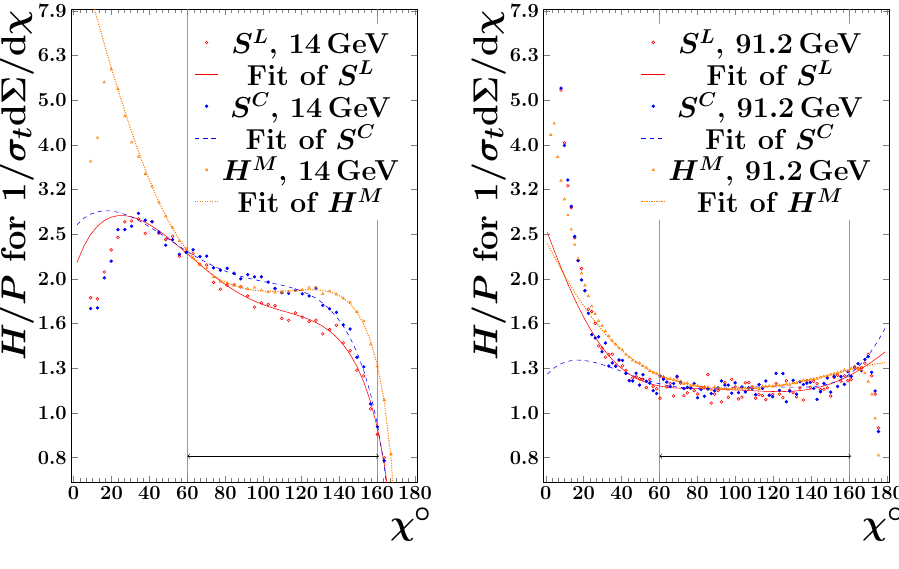
Figure 1. (left) The figure shows predictions for the ratio of EEC values at parton and hadron level at √ s = 14 GeV by various generators as indicated. The solid lines are parametrisations of the distribu- √ s = 91 . 2 GeV [1]. tions. (right) The same as for (left) but at